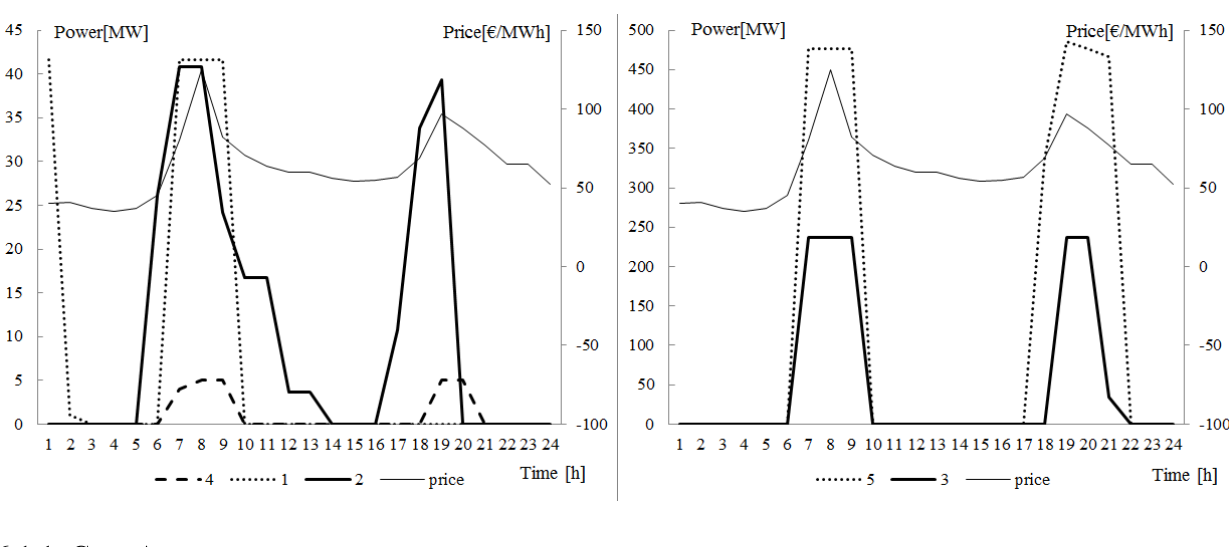
Figure 6. Optimal HC dispatch in base model.